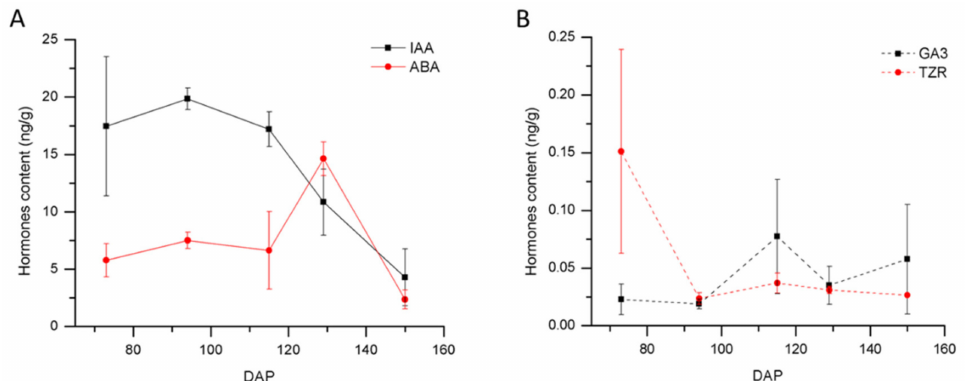
Figure 3. Changes of IAA ( A ), ABA ( A ), GA 3 ( B ), and TZR ( B ) contents at di ff erent developmental stages of P. armeniacum . The hormone contents are expressed as ng g − 1 fresh weight (FW). n = 3; ± SD. One-hundred milligrams of seeds were collected from six capsules in each biological replicate. Seeds used for hormones content analysis were harvested at 73 DAP, 94 DAP, 115 DAP, 129 DAP, and 150 DAP. The raw spectra of each hormone is now included in Figure